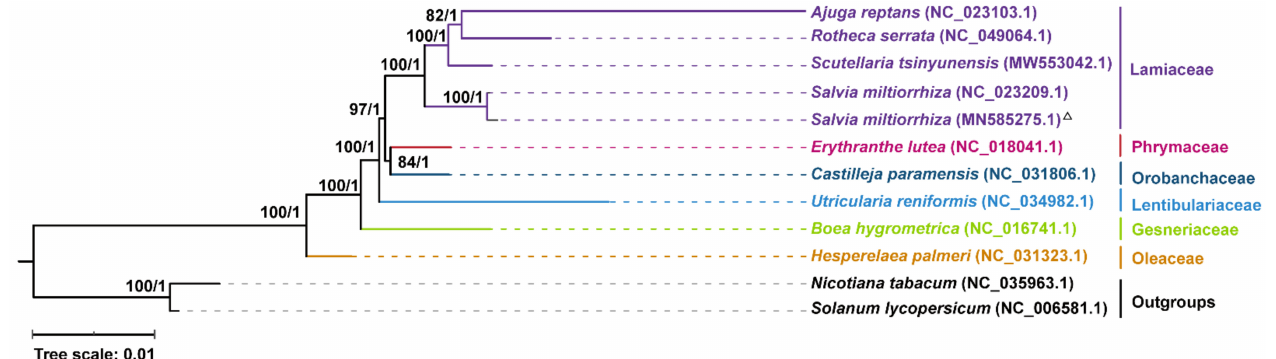
Figure 7. Molecular phylogenetic analysis of mitogenomes in Lamiales. The tree was constructed using concatenated conserved protein sequences from the mitogenomes of nine species via the ML and BI methods. The bootstrap score was obtained using 1000 replicates. The ML bootstrap support values and BI posterior probabilities were labeled at the corresponding nodes. Two species from Solanaceae ( Nicotiana tabacum and Solanum lycopersicum ) were used as outgroups. The mitogenome assembled in this study was labeled with a triangle. The species belonging to Lamiaceae , Phrymaceae , Lentibulariaceae , Gesneriaceae , Oleaceae were labeled with the colors of purple, peach, dark green, blue, green, and orange, respectively.